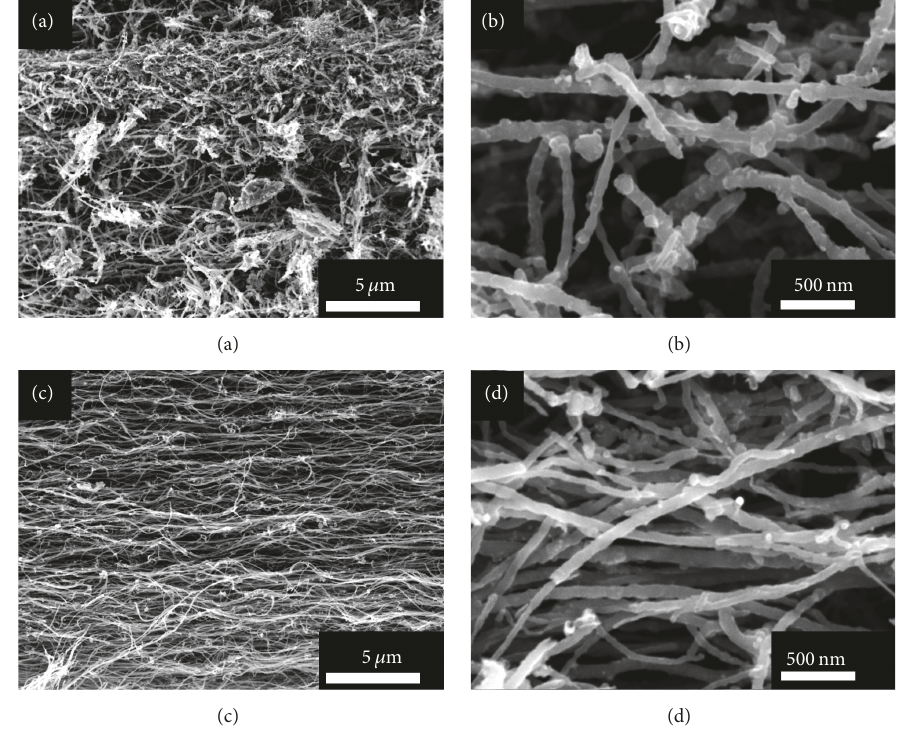
Figure 3: SEM micrographs of CNTs: (a-b) as-synthesized and (c-d) after purification process, at different magnifications.